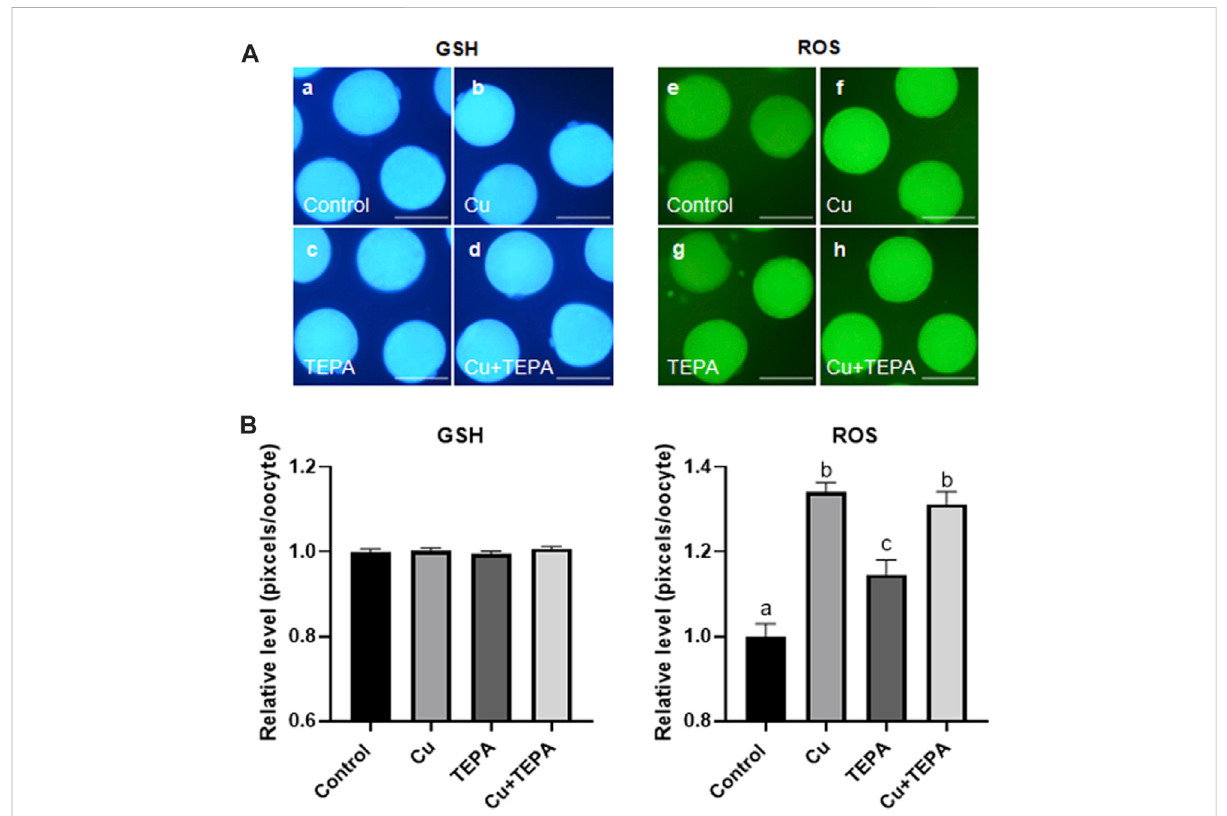
FIGURE 4 Epi fl uorescence photomicrographic images of porcine oocytes matured in vitro . (A) Oocytes were stained using Cell Tracker Blue (a – d) and 2 ′ ,7 ′ -dichlorodihydro fl uorescein diacetate (e – h) to measure the intracellular levels of glutathione (GSH) and reactive oxygen species (ROS), respectively. Metaphase II (MII) oocytes derived from in vitro maturation (IVM) in the presence of Cu or TEPA. Scale bar = 100 μ m. (B) Effect of Cu supplementation and chelation during IVM on the intracellular GSH and ROS levels in matured porcine oocytes. Within each group (ROS) of endpoints, the bars with different letters (a – c) are signi fi cantly different ( p < 0.05). GSH samples, N = 30; ROS samples, N = 30. For all graphs, the values represent the mean ± SEM. The experiment was replicated three or four